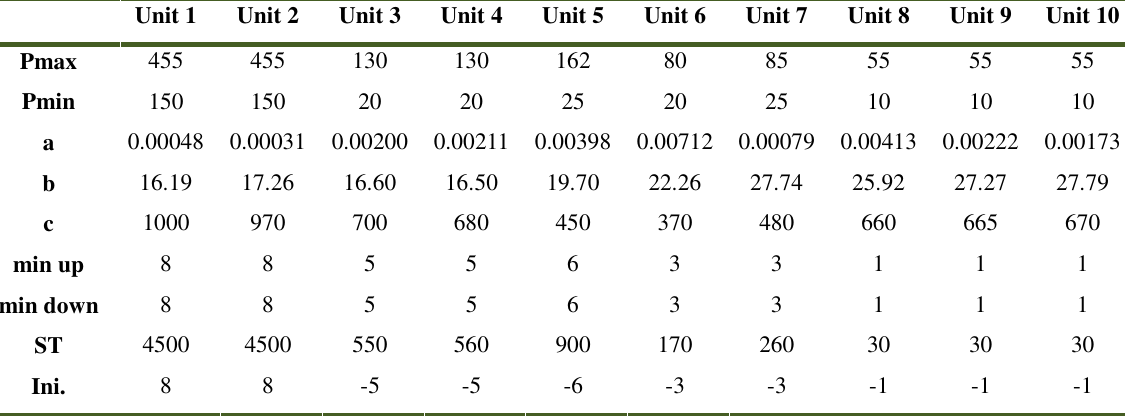
TABLE A4 Unit Data (Ten-unit 24-Period